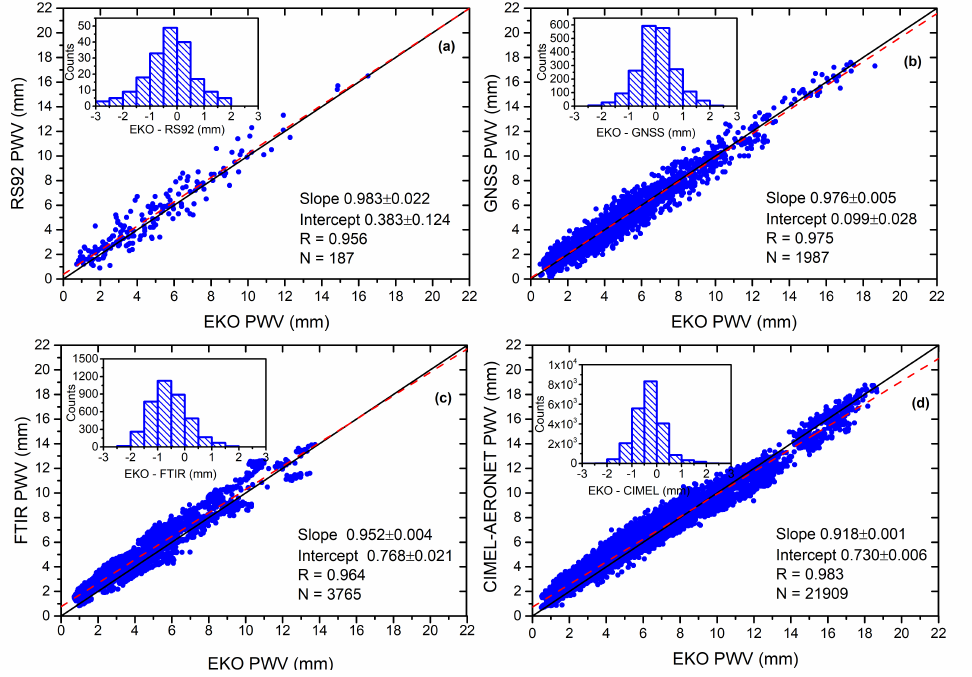
Figure 7. Scatterplot of EKO PWV (mm) versus ( a ) RS92 PWV, ( b ) GNSS PWV, ( c ) FTIR PWV, and ( d ) CIMEL-AERONET PWV between April and December 2019 at IZO. The dotted lines are the least-squares fits and the black solid lines are the diagonals (x = y). The least-squares fit parameters are shown in the legend (slope, intercept and Pearson correlation coefficient R). N is the amount of data. The small figures represent the occurrence distributions of the mean bias in mm (EKO PWV- XXX